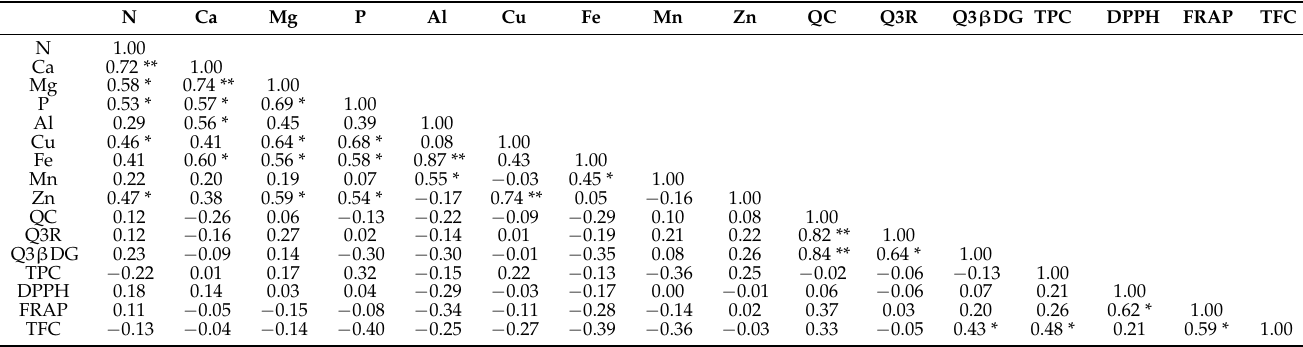
Table 6. Pearson correlation coefficient for mineral content, phenolic compounds, and antioxidant activities of spider plant.